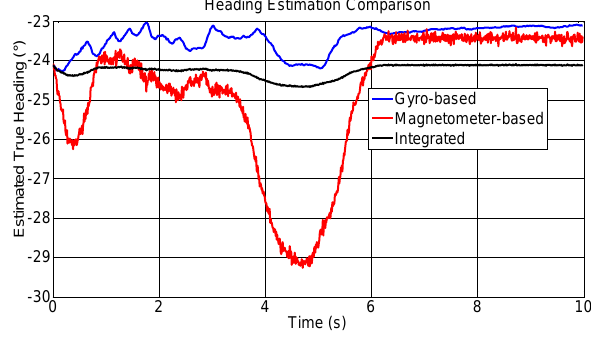
Figure 3. Heading solutions comparison between the gyro- based (blue), the magnetometer-based (red) and the proposed integrated solutions (kinematic case with magnetic